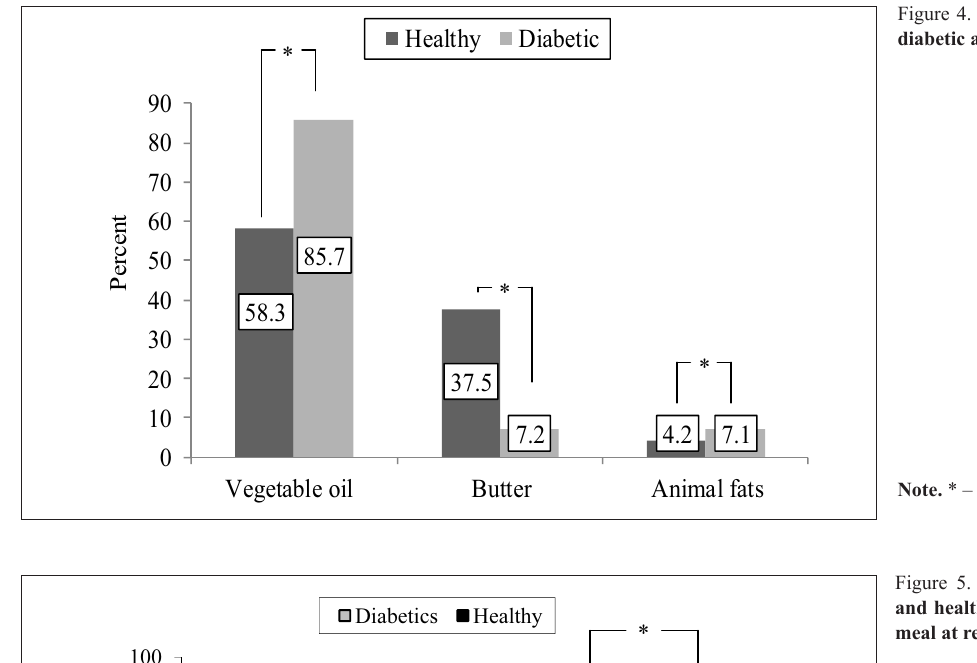
Figure 4. Structure of fat use by diabetic and young women